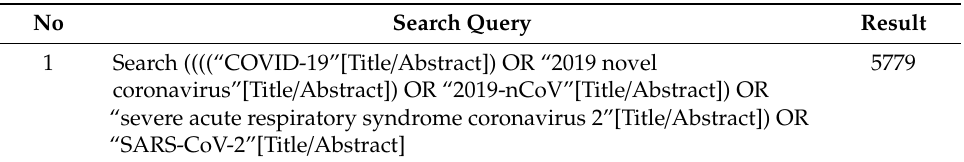
Table A2. Search query (MEDLINE /